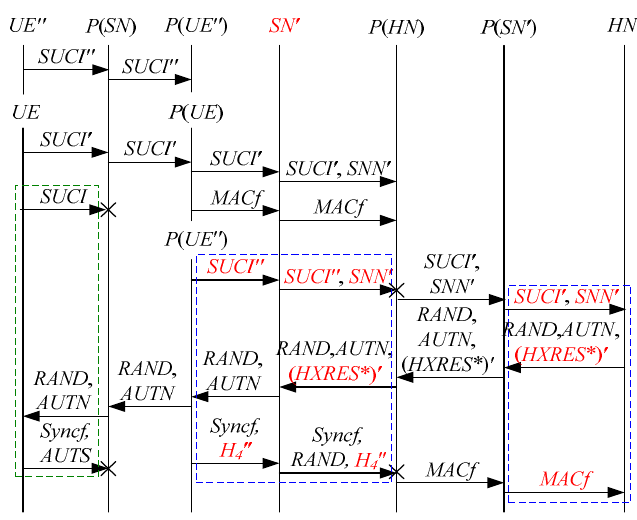
Figure 9. The eighth attack scenario of the 5G AKA protocol.